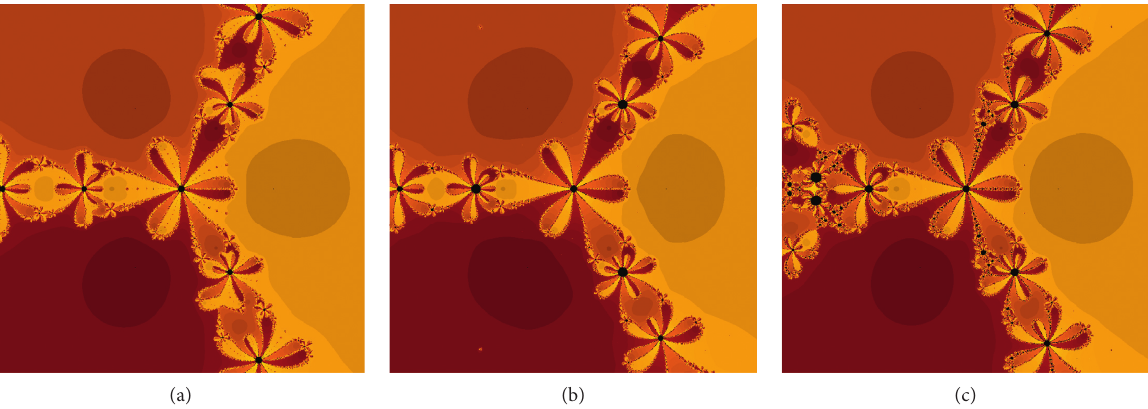
Figure 1: Basins of attraction associated with the polynomial p Algorithm 3.